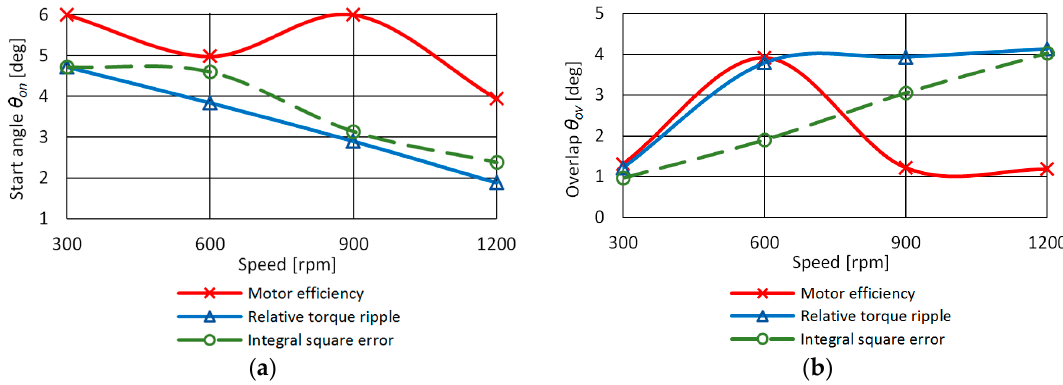
θ on ; ( b ) overlap ov